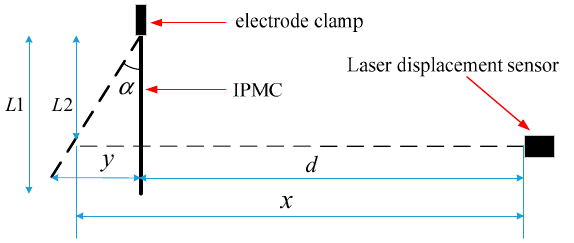
Figure 3. Displacement compensation diagram of IPMC actuators.